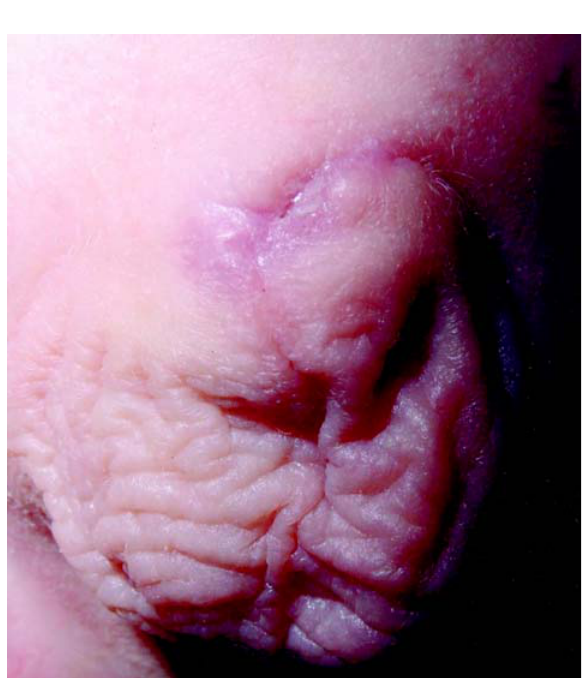
Figure 1 – Concealed penis after